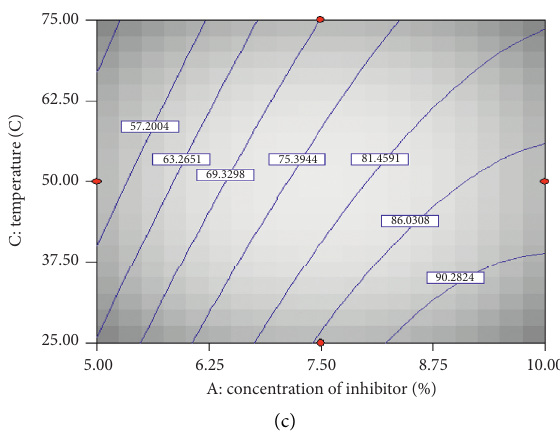
Figure 15: Contour plot of inhibition efficiency as a purpose of inhibitor load and temperature at the rotational speeds (a) 250rpm, (b) 200rpm, and (c)